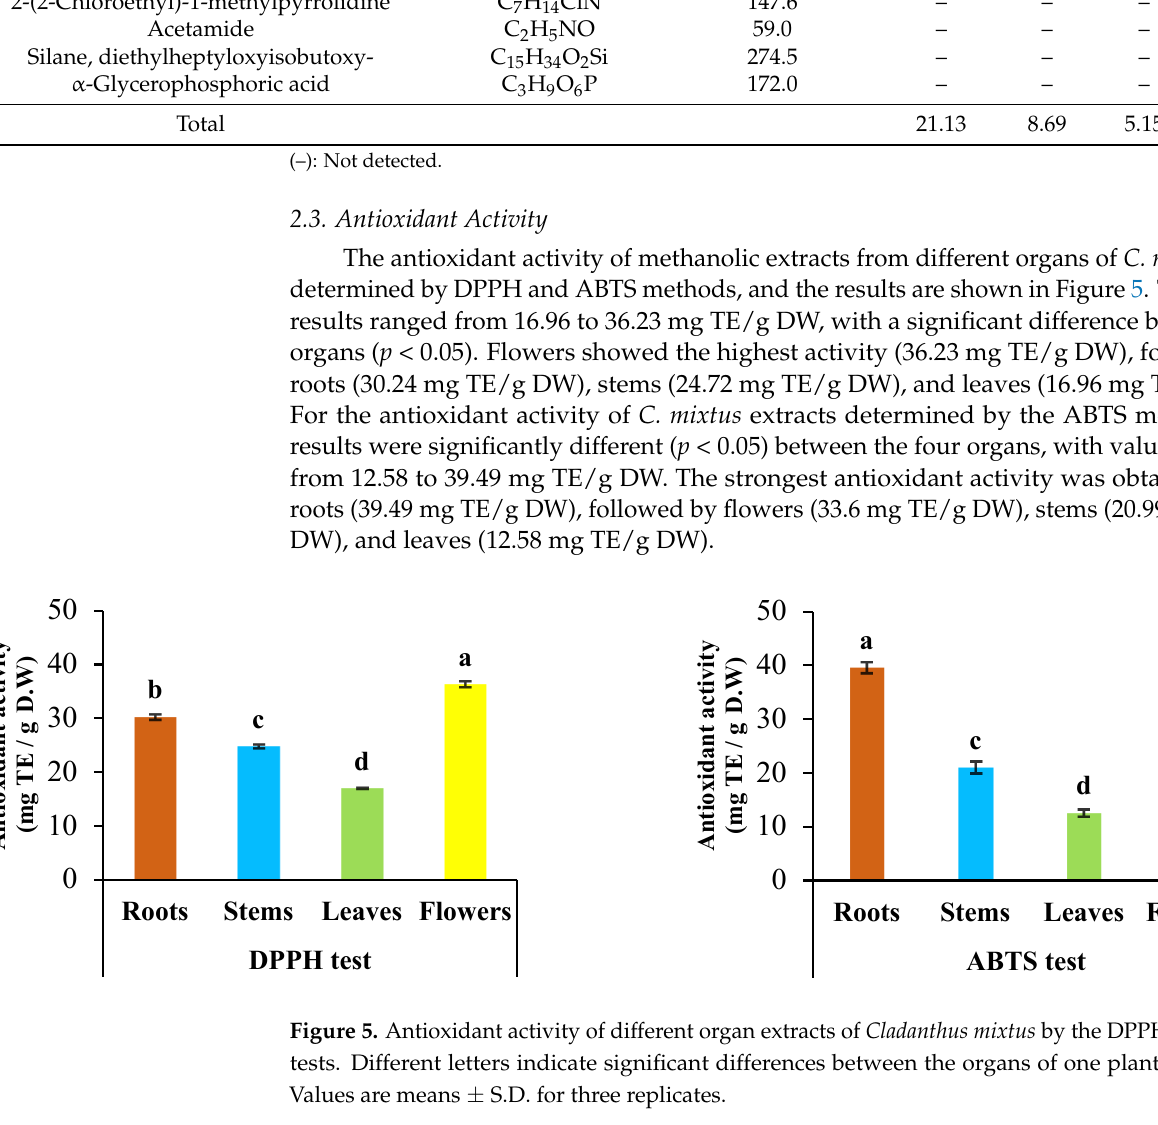
Table 10. MIC and MBC values of methanolic extracts of Cladanthus mixtus and a reference antibiotic